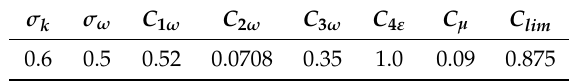
Table 2. Empirical coefficients for the k − ω 2006 turbulence